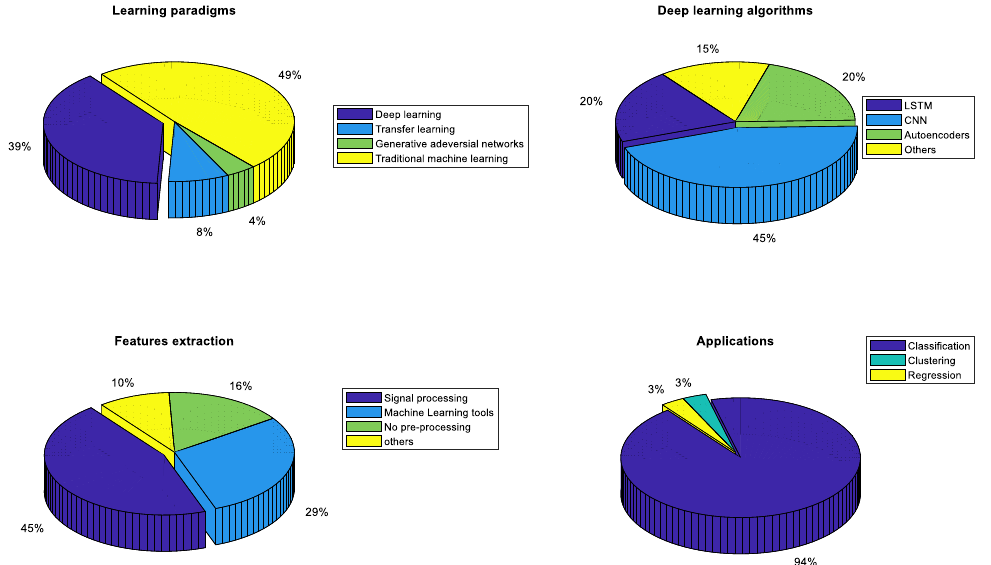
Figure 9. Pie chart analysis of the used machine learning methods in wind turbine condition moni-